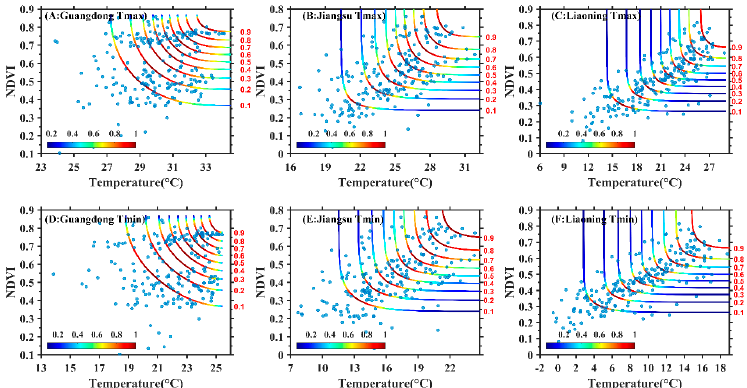
Figure 8. Copula joint probability distributions of Tmax–NDVI and Tmin–NDVI in autumn in Guangdong, Jiangsu and Liaoning from 1982 to 2016.